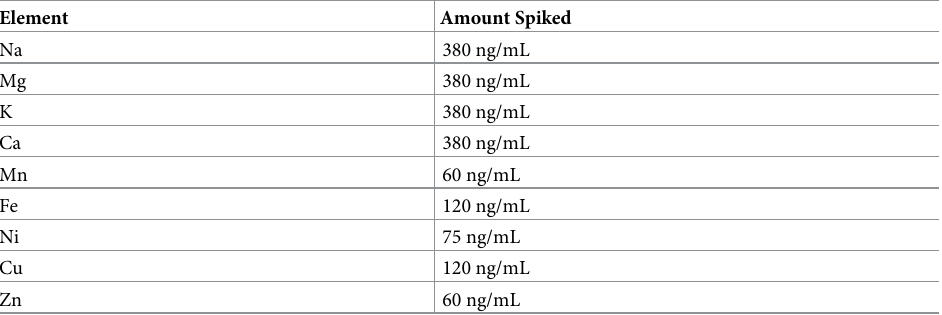
Table 1. The elements were added first as single elements and then as a mixture containing all of them. The ECPs were then treated similarly than before, and the recoveries were calculated. Table 1. Concentrations of metals used for the selectivity